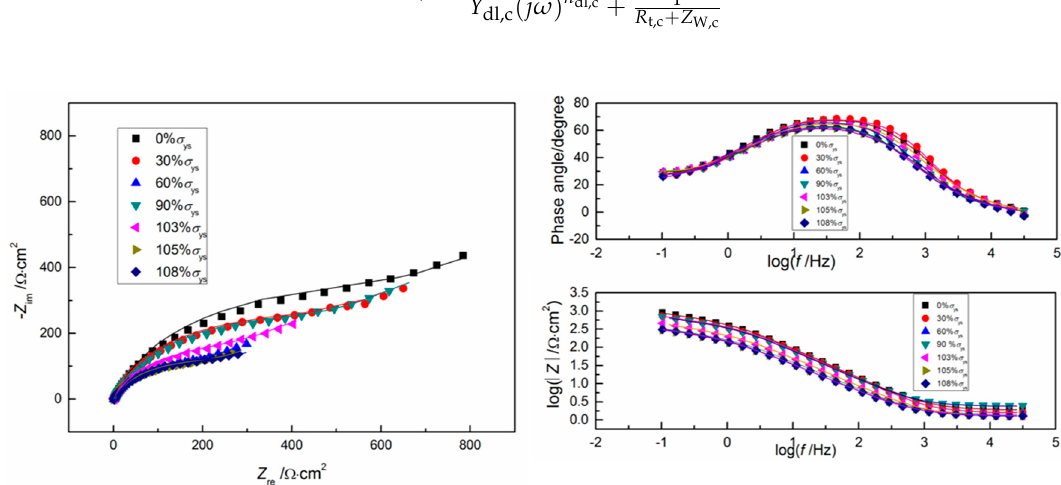
Figure 9. EIS curves of X80 steel measured at − 60 mV (vs. OCP) in 3.5 wt% NaCl aqueous solution with saturated CO 2 under different elastic and plastic tensile stress at 30 °C. Symbol: Experimental data; Line: simulation data.